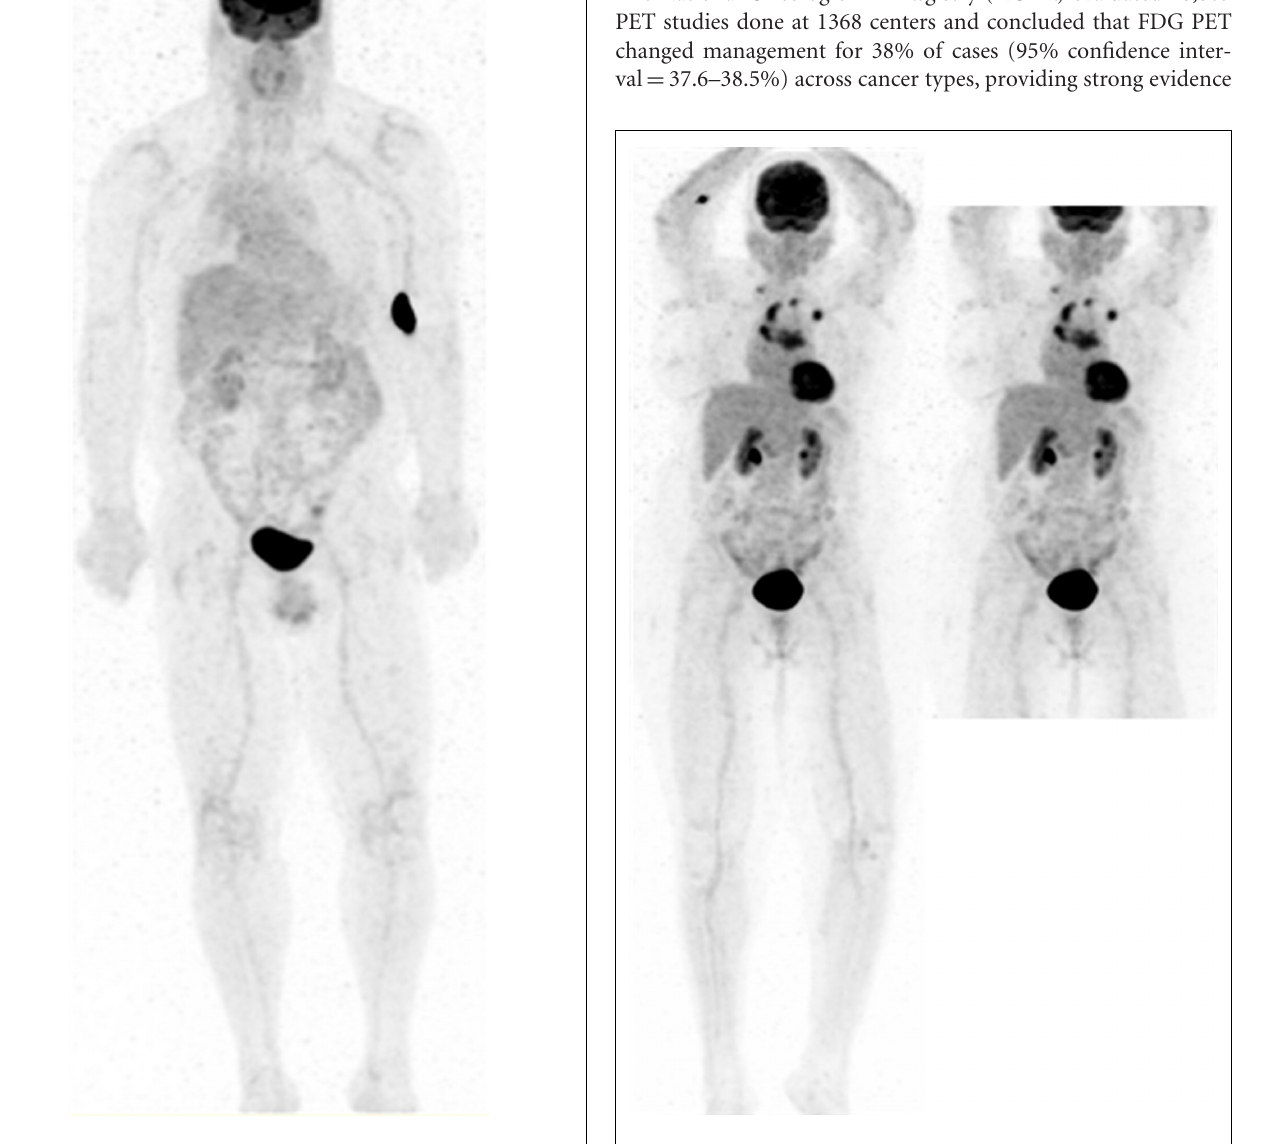
FIGURE 1 | Maximum intensity projection (MIP) PET image of a 63-year-old male with a history of esophageal cancer. Patient was injected in the left antecubital fossa (LAC) with dose extravasation (SUVmax 196) within the LWB FOV.